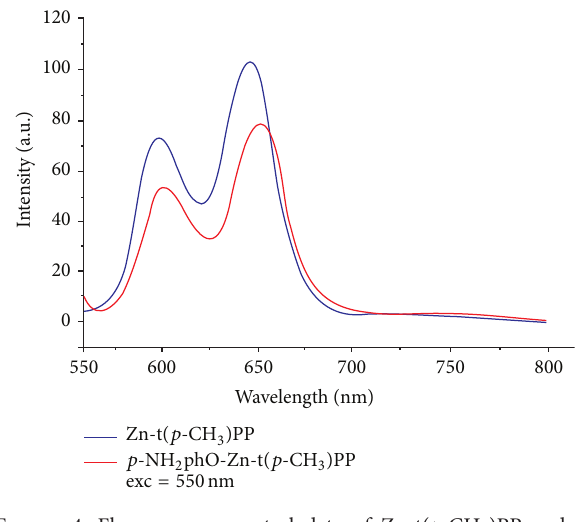
Figure 4: Fluorescence spectral data of Zn-t( p -CH 3 )PP and p -